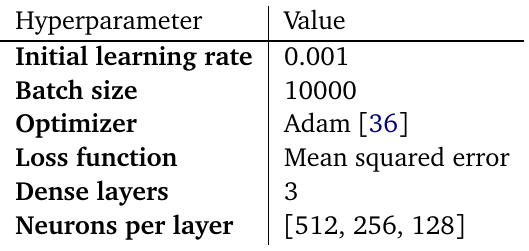
Table 2: Parameter combinations used for training the Deep SVDD models.